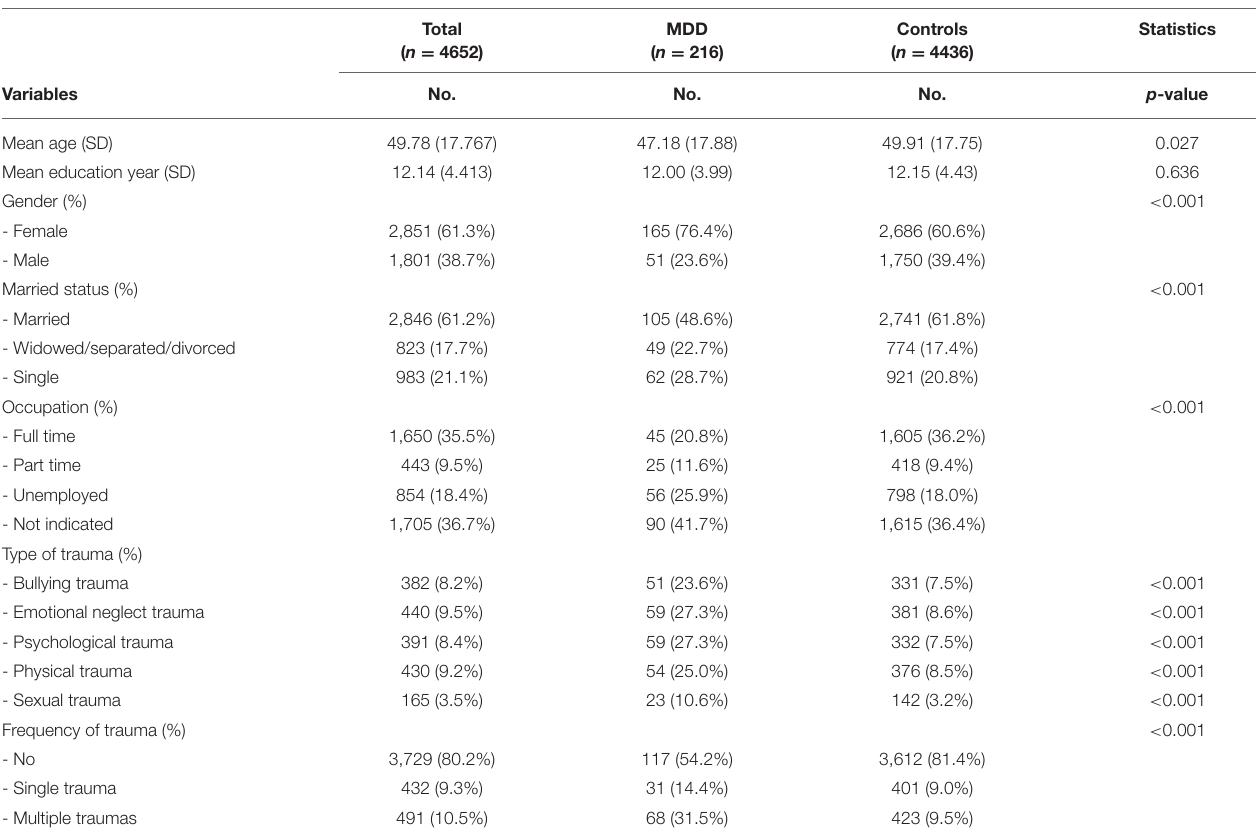
TABLE 1 | Comparison of the sociodemographic profiles of individuals with and without major depressive disorder (MDD) in participants from the Korean Epidemiological Catchment Area Study in 2016 (KECA-2016) ( N =